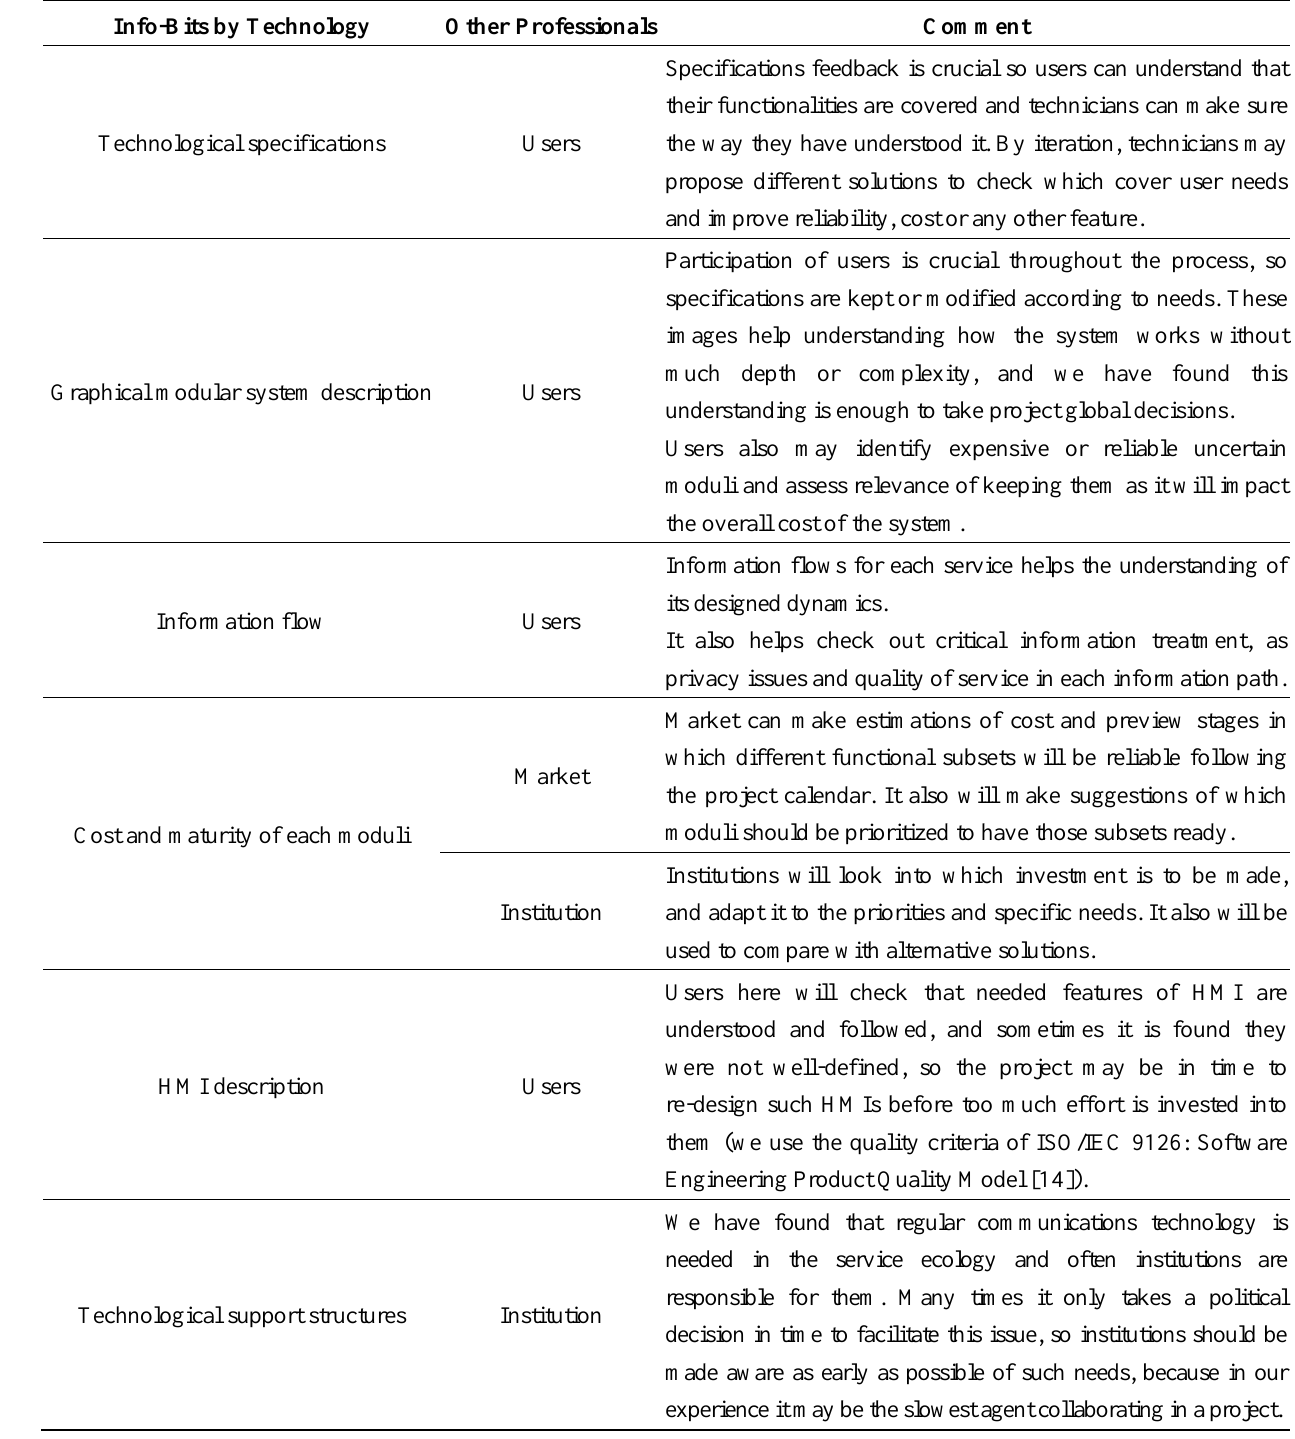
Table 2. Description of importance of information generated by technology-oriented professionals as received by other